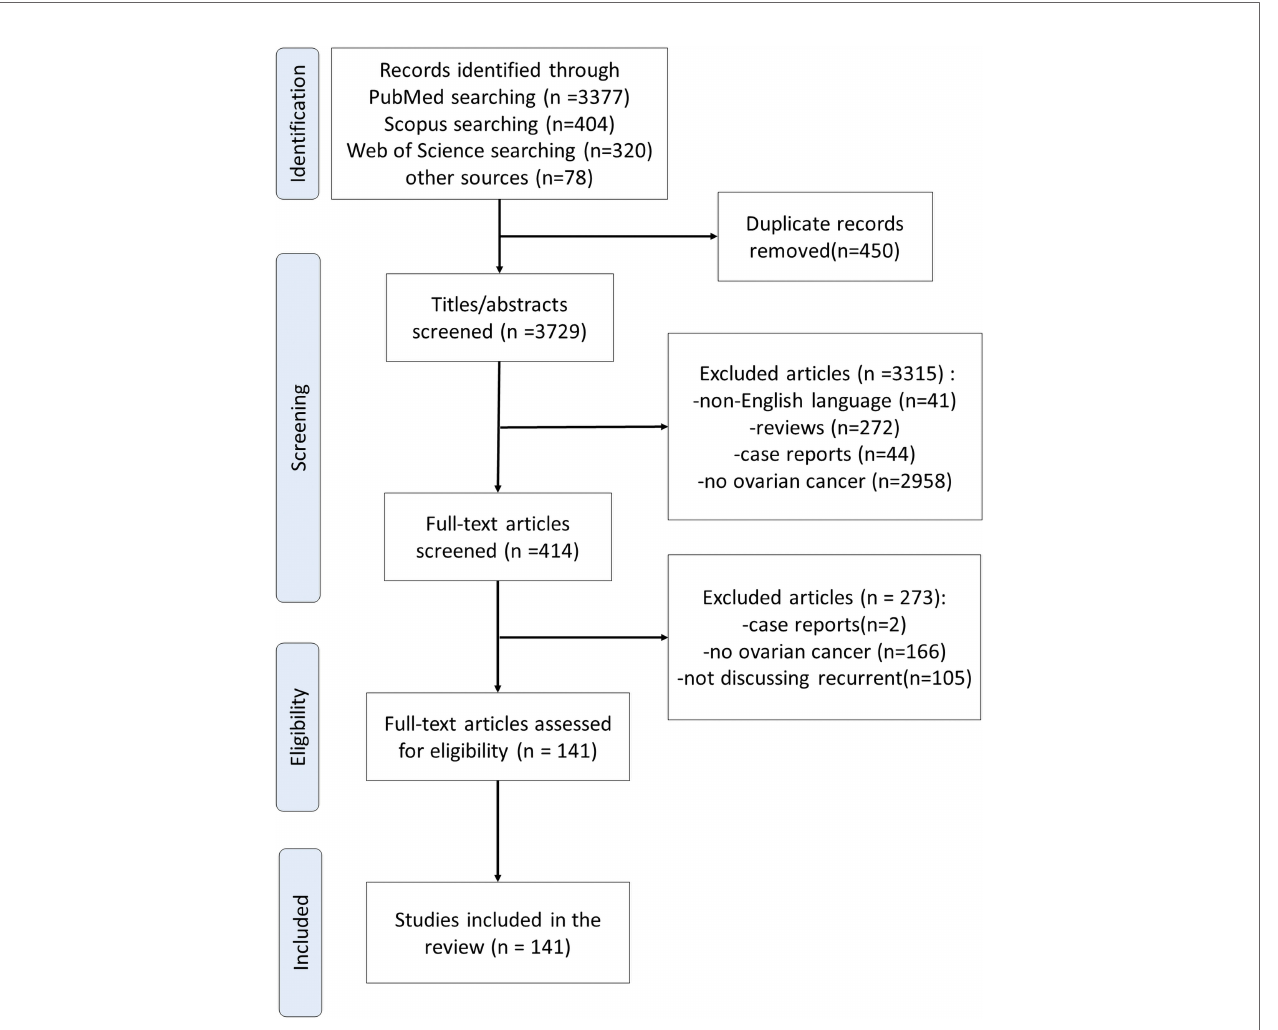
FIGURE 2 | Flow diagram of reference identi fi cation and